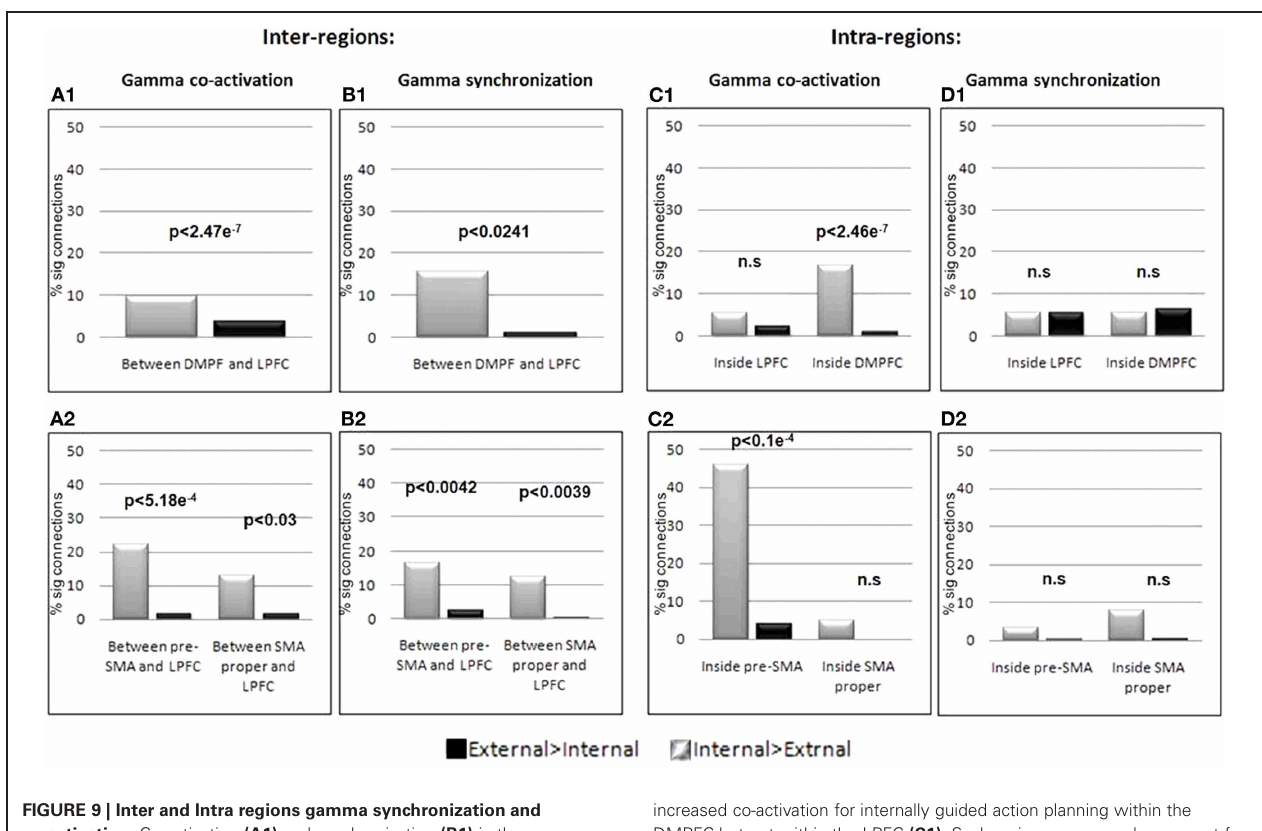
increased co-activation for internally guided action planning within the DMPFC but not within the LPFC (C1) . Such an increase was also present for the pre-SMA, but not the SMA proper (C2) . Within regions synchronization revealed no difference between the conditions (D1–2) . Significant difference between the conditions was tested using